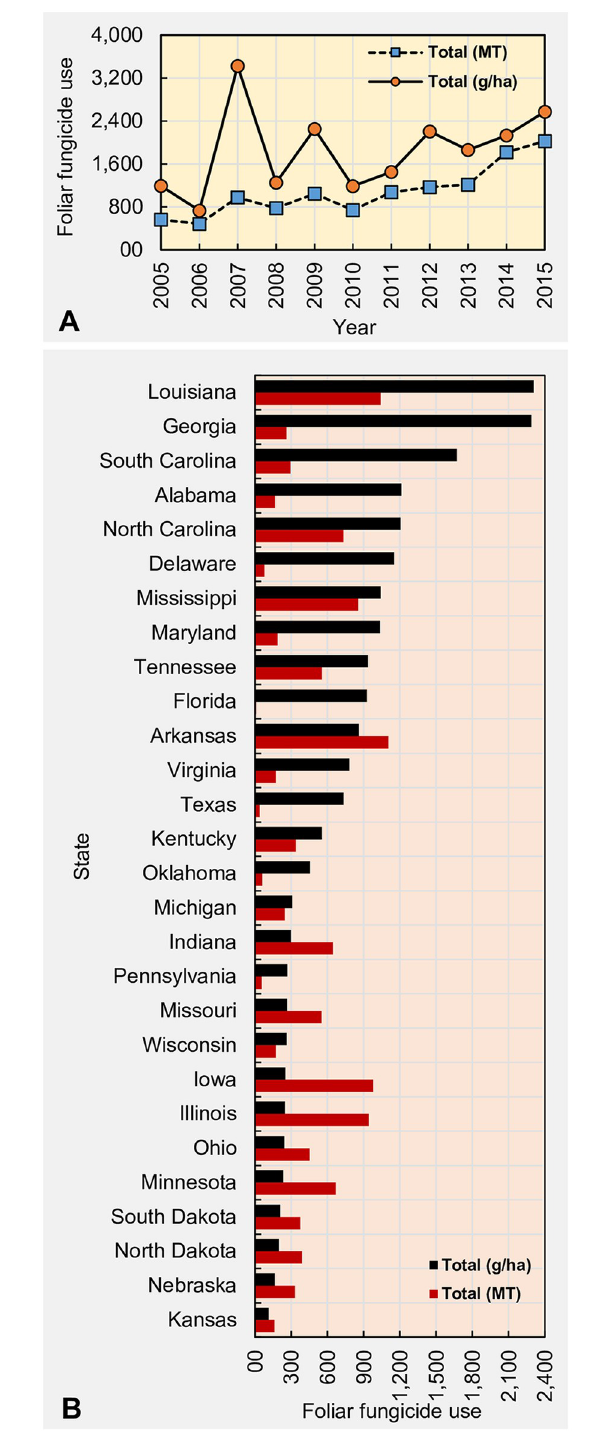
Fig 1. Spatiotemporal foliar fungicide use patterns in the United States. Temporal fluctuation for foliar fungicide use during 2005 to 2015 across all states considered (A) and state-wide use of cumulative foliar fungicides from 2005 to 2015 (B). Fungicides included: quinone outside inhibitors = azoxystrobin, fluoxastrobin, picoxystrobin, pyraclostrobin, trifloxystrobin; demethylation inhibitors = cyproconazole, difenoconazole, flutriafol, propiconazole, prothioconazole, tebuconazole, tetraconazole; methyl benzimidazole carbamates = thiophanate-methyl; multi-site mode of action = chlorothalonil; and succinate dehydrogenase inhibitors = fluxapyroxad.